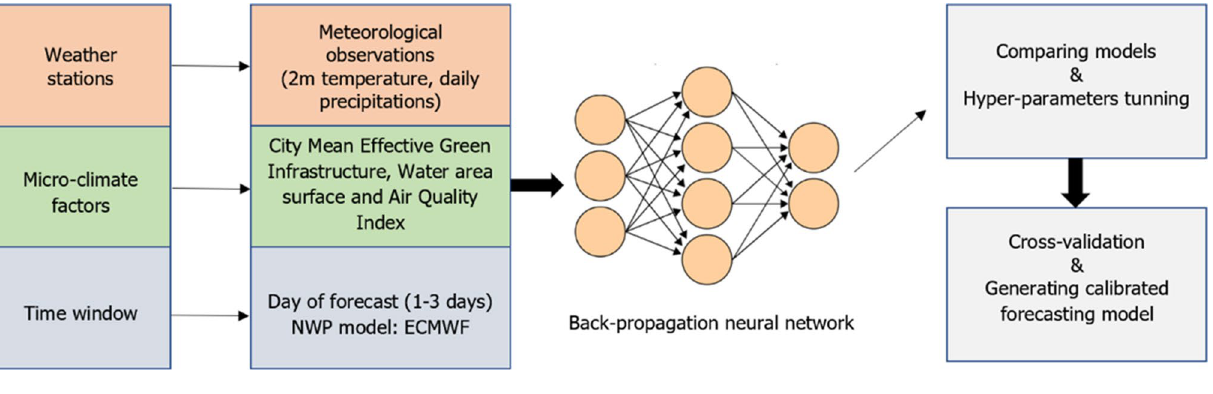
Figure 3. The architecture of the proposed